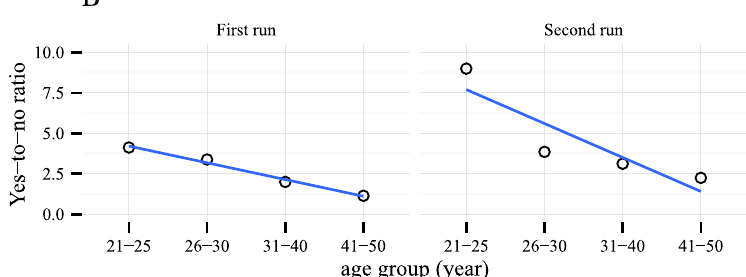
Figure 5. Students’ opinions of Angelina Jolie’s choice to do a mastectomy. (A) About half of the students supported Jolie’s choice in both runs. (B) Older students seemed more conservative than younger students about this